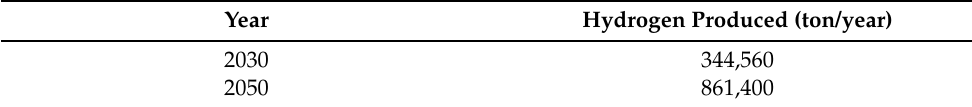
Table 12. Hydrogen Production on EGP